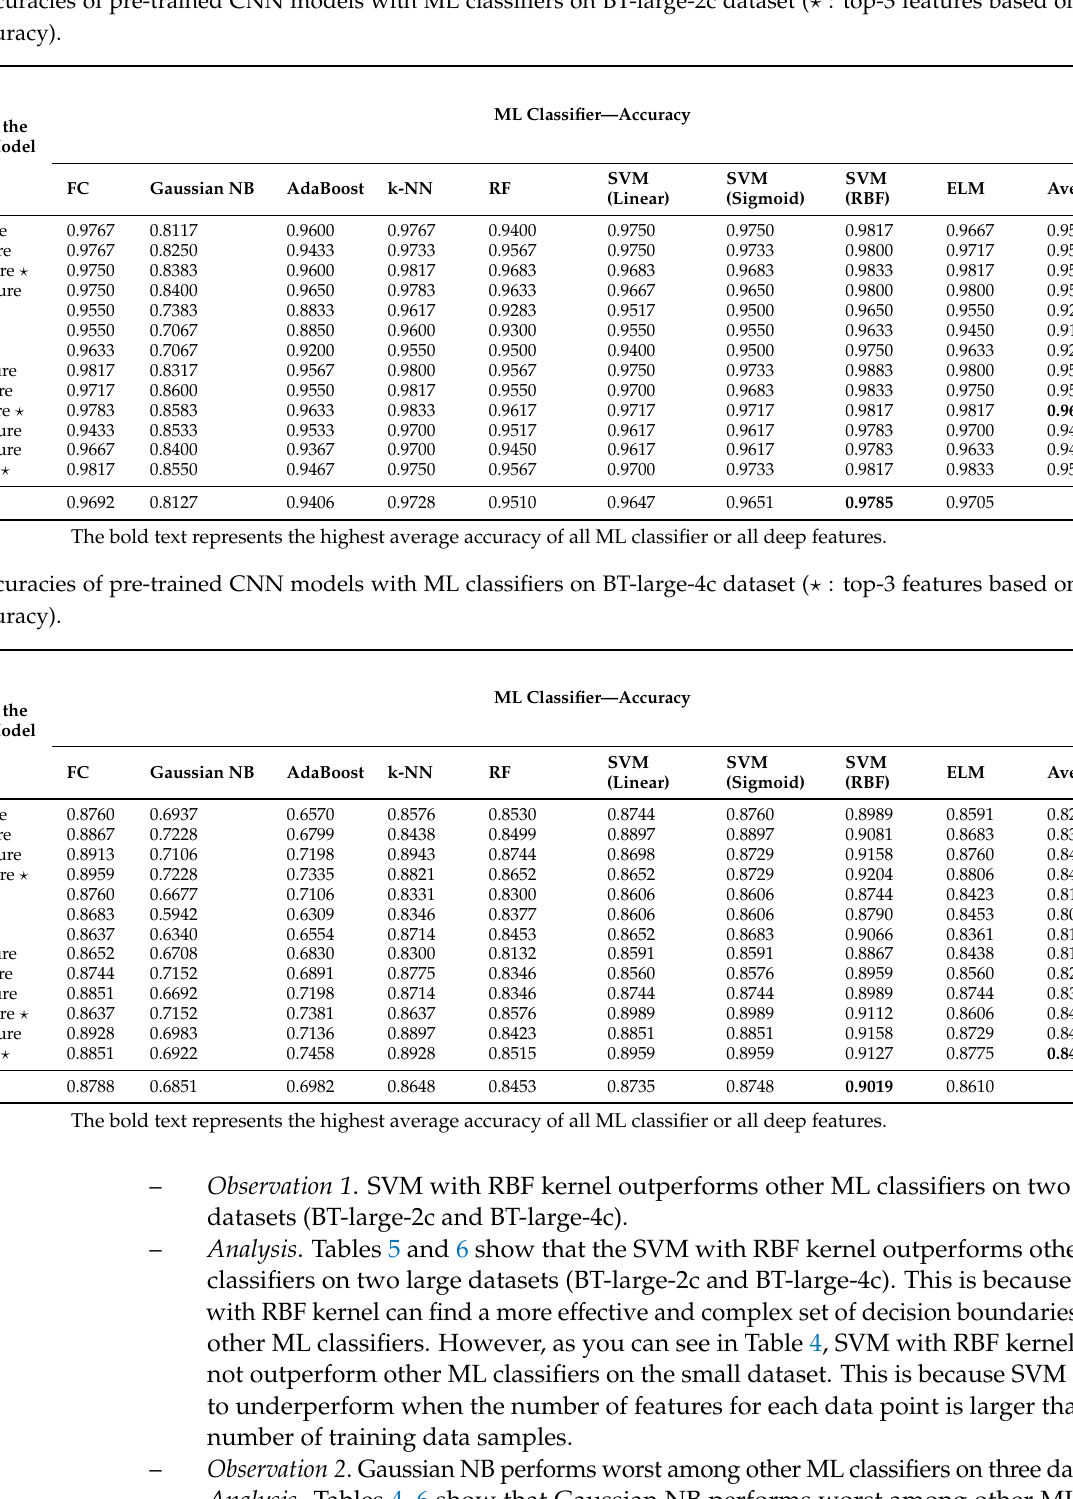
Table 5. Accuracies of pre-trained CNN models with ML classifiers on BT-large-2c dataset ( (cid:63) : top-3 features based on average accuracy).